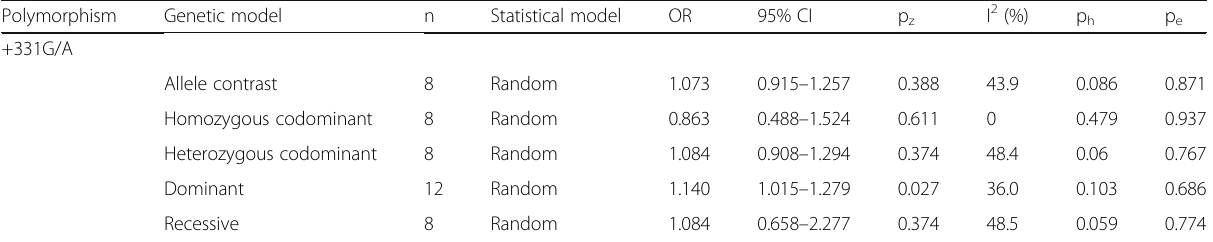
Table 3 Summarized ORs with 95% CIs for the association between PGR polymorphism and breast cancer